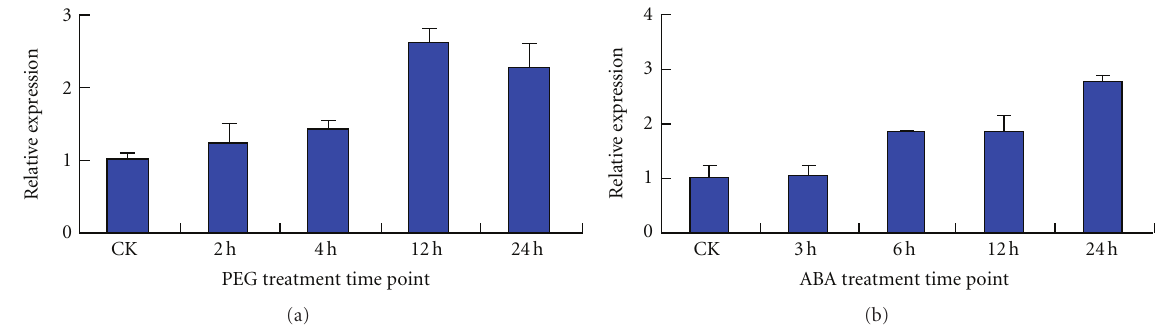
Figure 3: Expression profiling of ethylene insensitive gene (EU071774) in E. arundinaceum under PEG (a) and ABA (b) treatments.